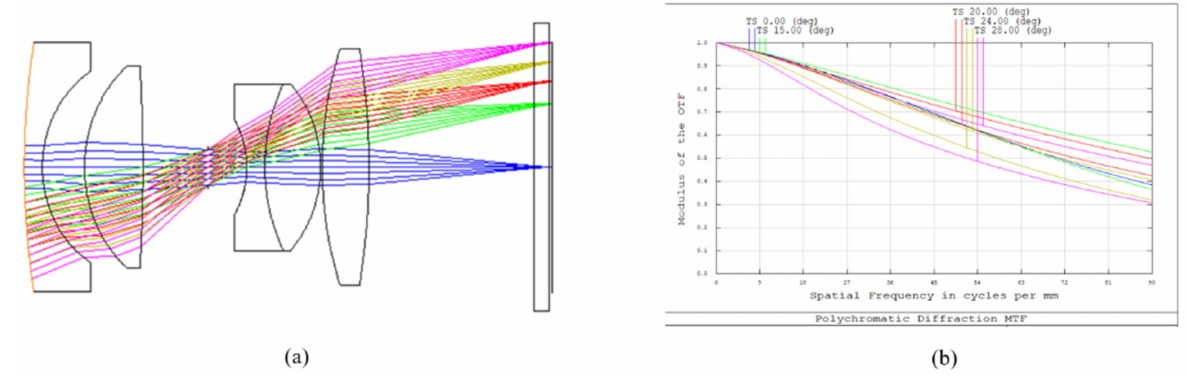
Figure 7. Wide-field optical system design and MTF curve. ( a ) Optical design; ( b ) MTF curve.